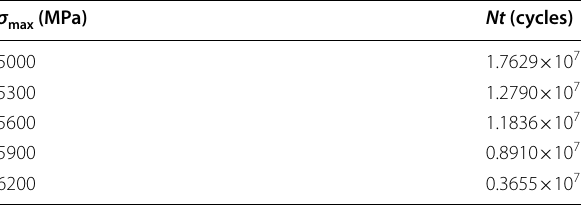
Table 5 Torsion experimental data for GCr15 at R σ max (MPa) Nt (cycles) 500